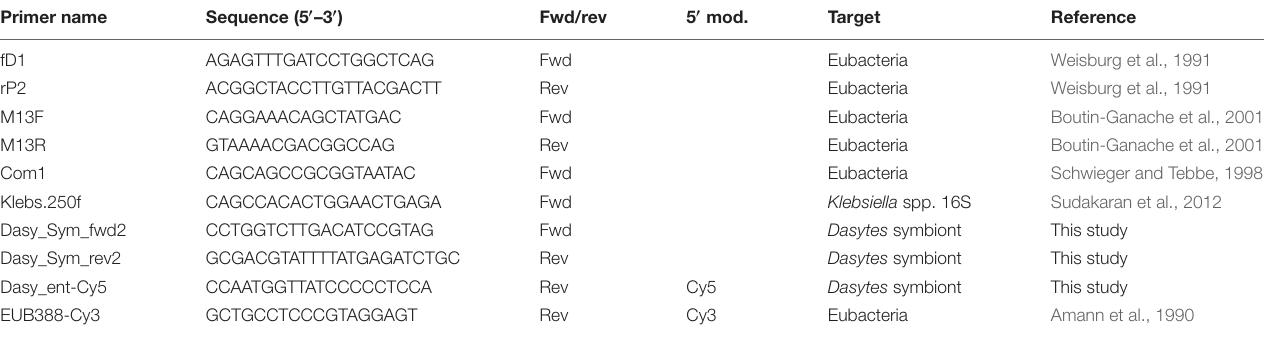
TABLE 1 | Primers and FISH probes used for identification and localization of